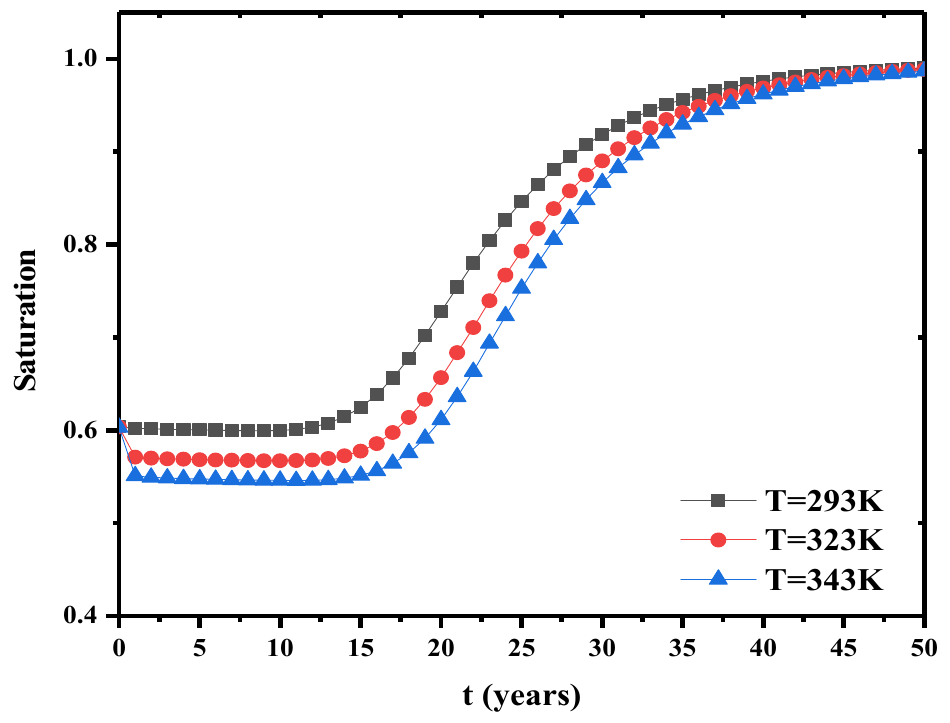
Figure 15. Saturation change under different initial temperatures.